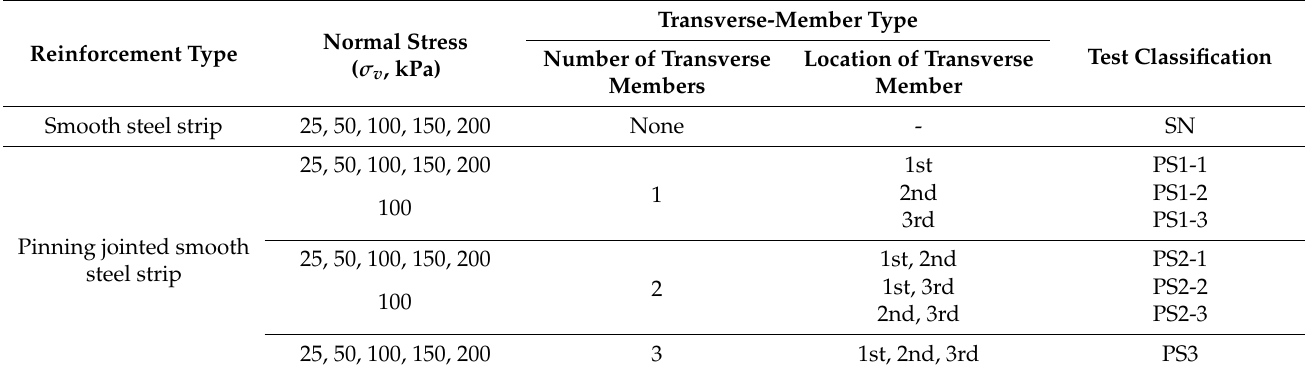
Table 2. Pullout testing